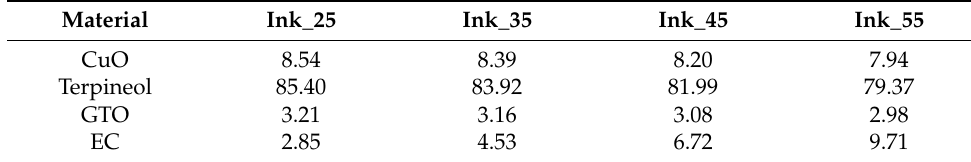
Table 1. Compositions of the CuO inks